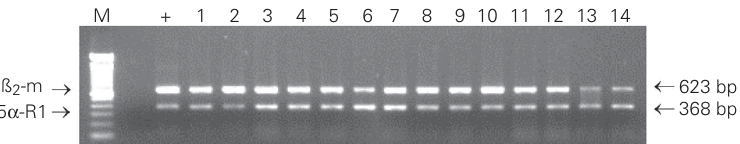
Figure 2. Representative gel showing SDR5A1 mRNA levels determined by RT-PCR in hair cells plucked from the scalp of men (1 to 7) and normal women (8 to 14). The 368-bp fragment corresponds to SDR5A1 (5 α -R1) and the 623-bp fragment corresponds to ß 2 - microglobulin (ß 2 -m). RT-PCR products were visualized on agarose gel stained with ethi- dium bromide. + = positive control.